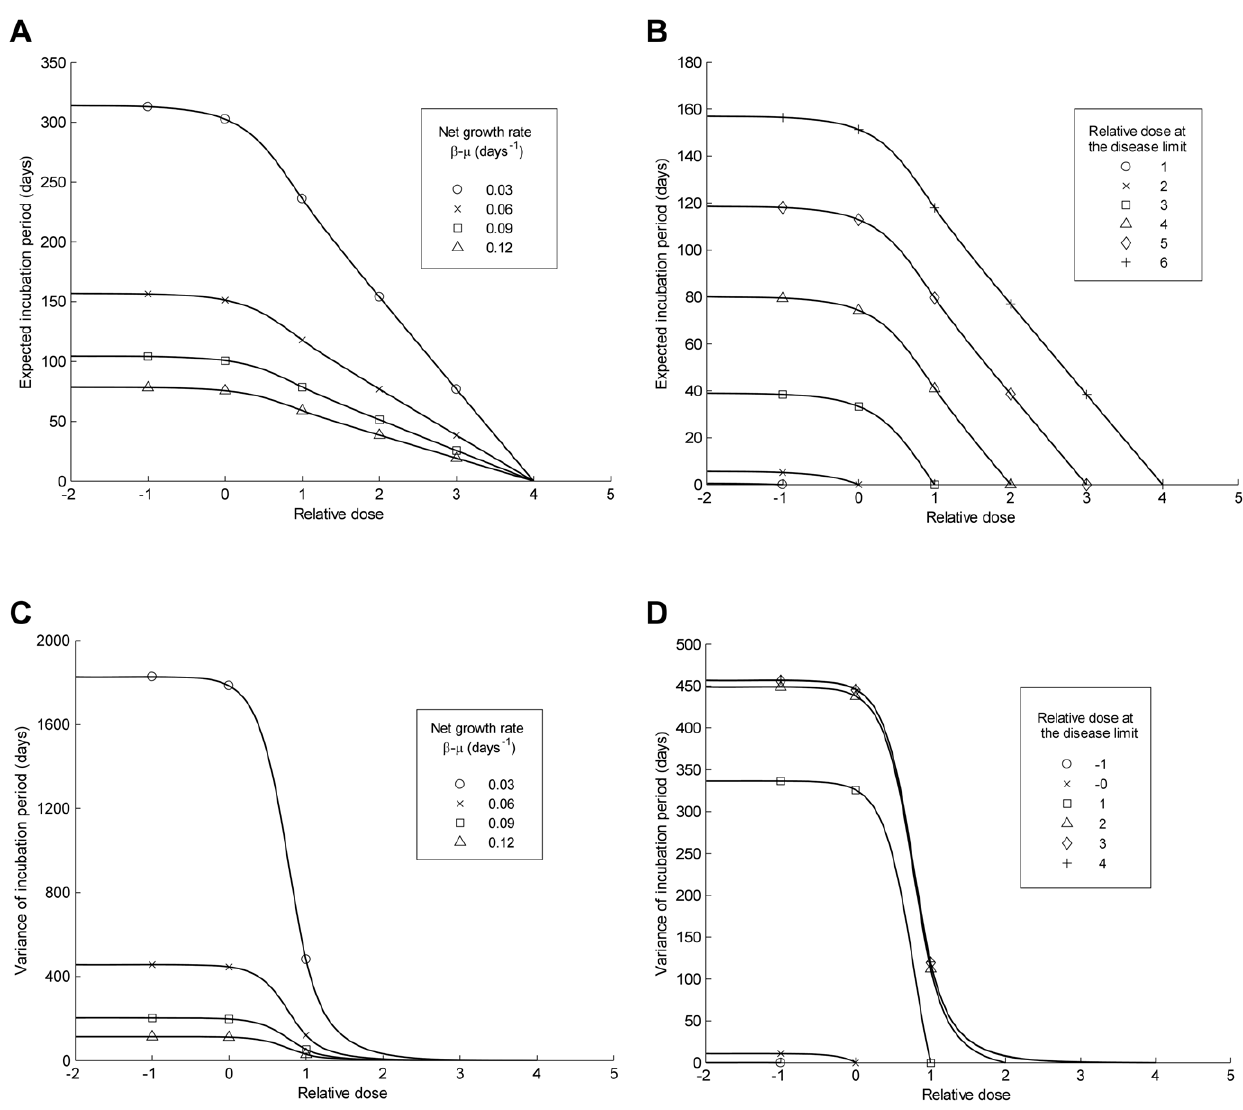
Figure 3. Model predictions showing how the expectation and variance of the incubation period vary according to the relative dose (RD), the net growth rate ( b - m ) and the relative dose at the disease limit (RD L ). A) and B) show factors affecting the expectation of the incubation period. The expected incubation period is approximately invariant to the inoculating dose for relative doses less than approximately 0 (the ID50). Beyond approximately 0, the incubation period decreases linearly with relative dose. A) shows that the gradient of this slope is steeper if the net growth rate of prions ( b - m ) is smaller. Specifically the gradient is equal to { ln(10) = ( b { m ) . B) shows that the expectation of the incubation period is also larger if the relative dose at the disease limit is larger. C) and D) show factors affecting the variance of the incubation period. The variance is approximately invariant to dose for doses less than relative dose 0. Beyond 0 the variance decreases as the dose increases. The variance also increases as the relative dose at the disease limit increases, but has an upper bound that is reached when the relative dose at the disease limit is greater than 3. Thus the maximum variance is determined by the net growth rate ( b - m ). In panels A) and C) the relative dose at the disease limit is assumed to equal 4. In panels B) and D) the net growth rate is assumed to equal 0.06 days 2 1 . We also assumed that at relative dose –2 there was 1 prion in the population. This assumption truncates the graphs at relative dose –2, but does not change the shape of the graphs. The data included in this figure are from 119 experiments for which an ID50 could be calculated.